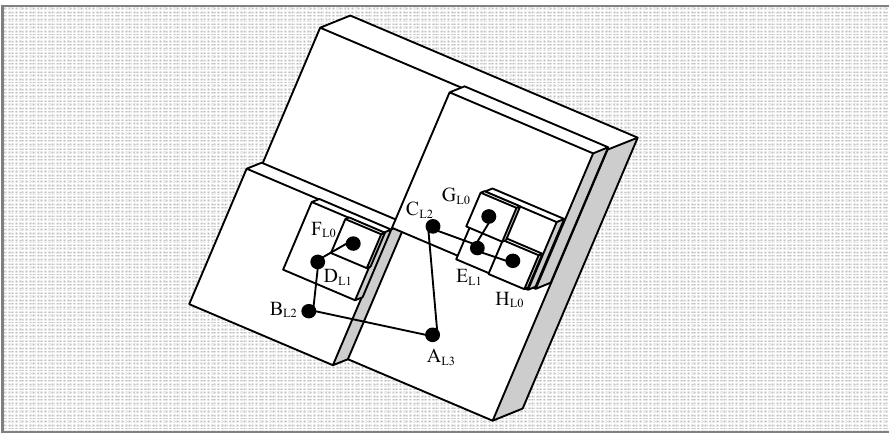
Figure 3. An Illustration of the Distributed Index for Features (DIFS)